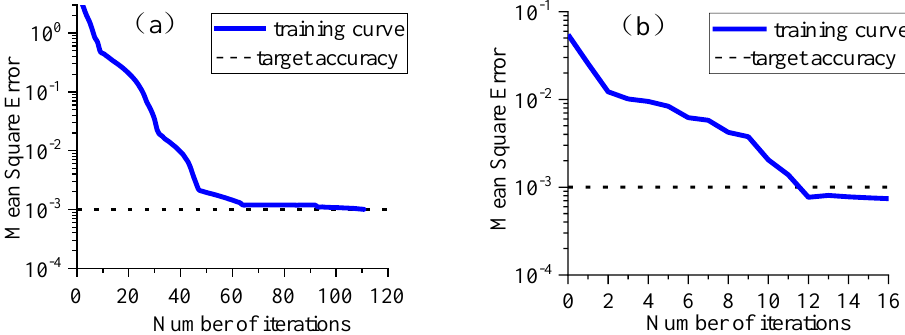
Figure 10. Error convergence curve; ( a ) BP neural network; ( b ) RBF neural network.